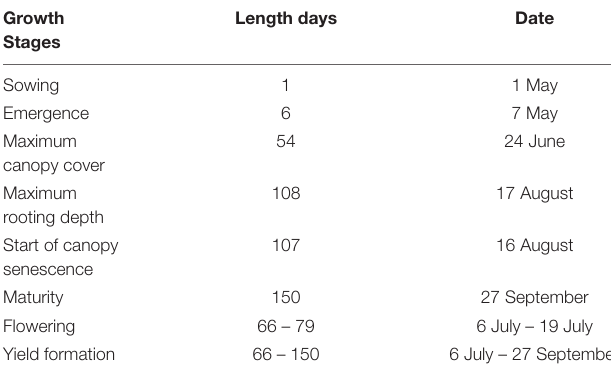
TABLE 2 | Phenological information of maize in the black soil area of Northeast China.